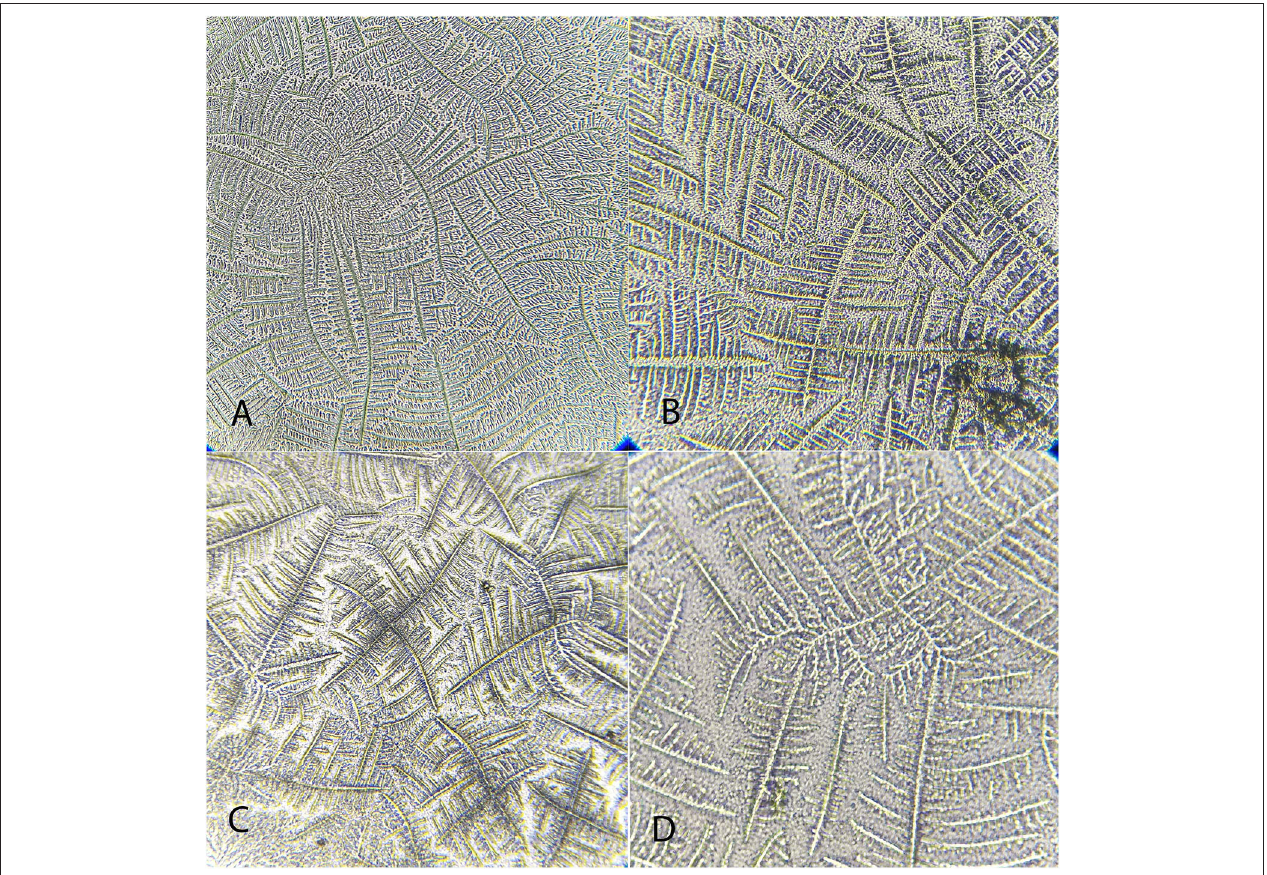
FIGURE 8 | Examples of Rupornis magnirostris tear ferning patterns, according to the Rolando and Masmali grading scales. (A) Type 1 (Rolando scale), grading 1 (Masmali scale); (B) Grading 2 (Masmali scale); (C) Type II (Rolando scale); (D) Grading 3 (Masmali